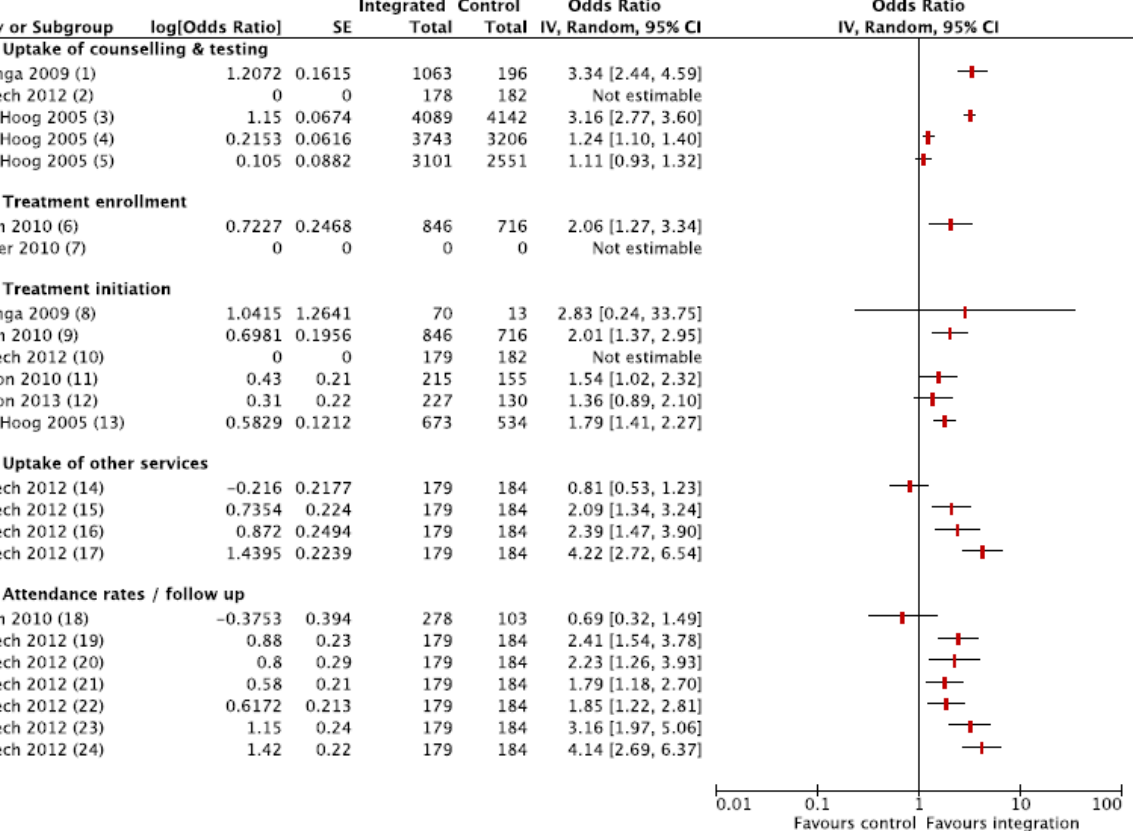
Figure 2. Uptake and utilisation of HIV services (integrated care vs controls). (1) HIV testing within ANC; (2) Infant DBS–PCR testing at 6–8 weeks; (3) Pre–test counselling; (4) Post–test counselling; (5) HIV testing within ANC; (6) Enrollment to HIV–care within 60 days of diagnosis; (7) Women registered for HIV care <30 days post–test (missing data, contact); (8) Nevirapine at delivery; (9) ART initiation during pregnancy; (10) Infant CTX initiation at 6–8 weeks (100% success in intervention group); (11) ART; (12) HAART; (13) Nevirapine uptake; (14) Measles immunization at 9 months; (15) Oral polio vaccine at 14 weeks nths; (16) Complete vaccina- tion by 12 months; (17) DPT vaccine at 14 weeks; (18) 90–day retention among patients initiating ART; (19) 9–month postnatal visit; (20) 6–month postnatal visit; (21) Continuation of CTX prophylaxis at 6 months; (22) 14–week postnatal visit, (23) 12–month postnatal visit; (24) HIV antibody test at 12